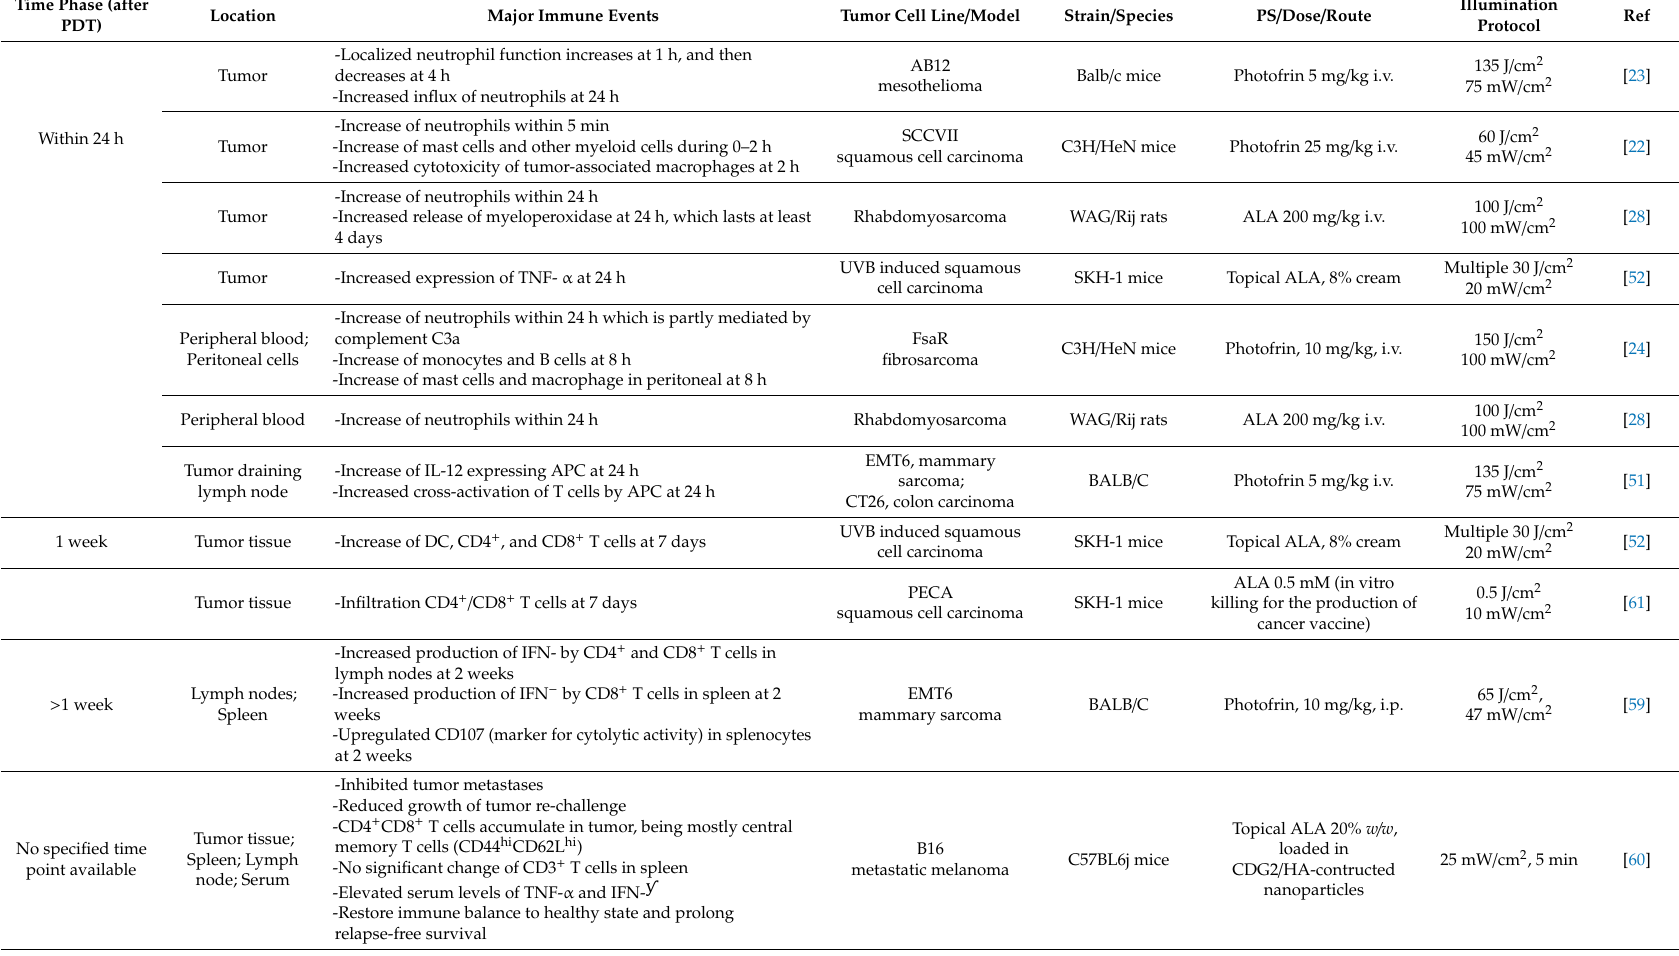
Table 2. Preclinical studies on immune responses to Photofrin- or ALA-PDT in cancer